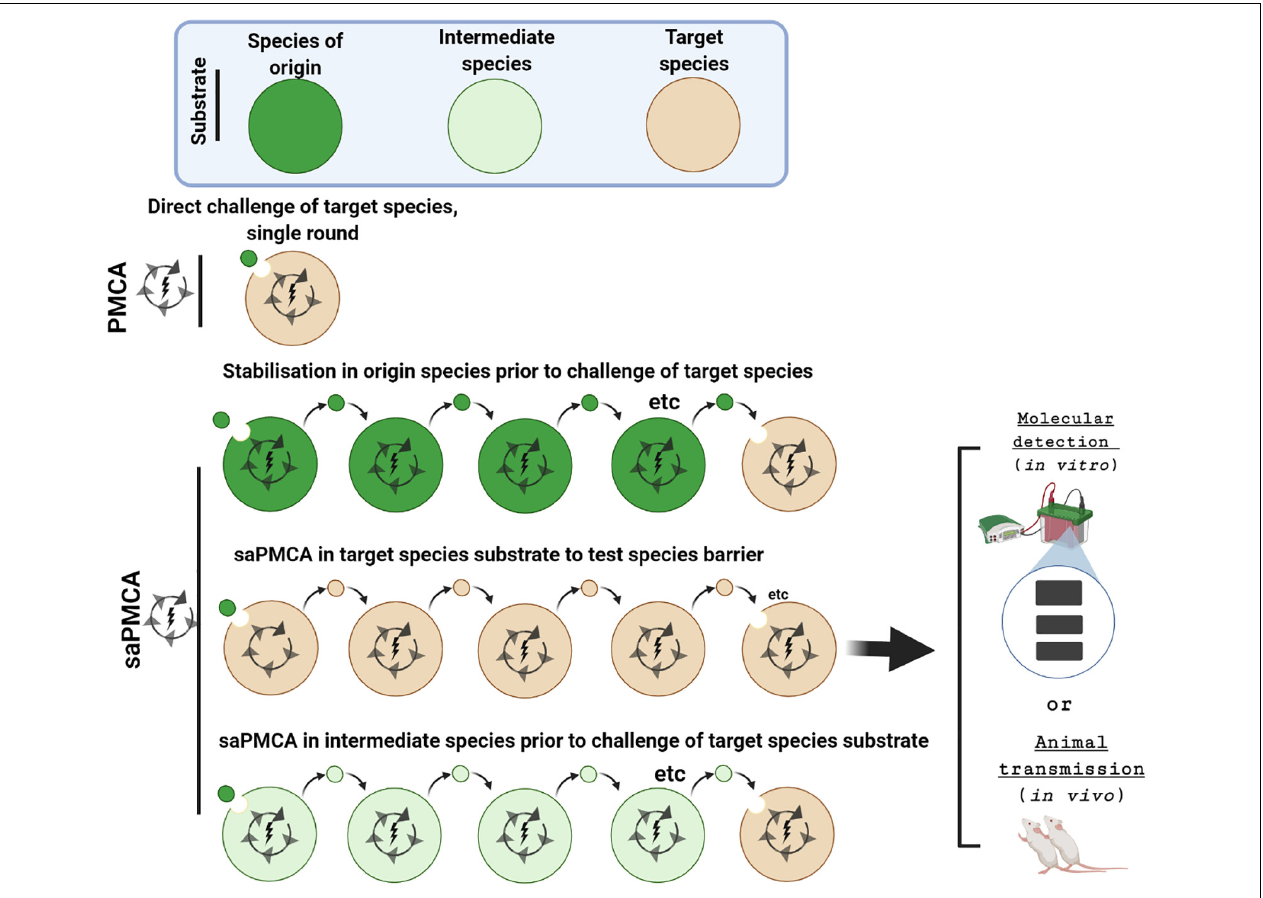
FIGURE 3 | Investigating inter-species transmissibility by PMCA and saPMCA. The potential for a prion strain to cross the species barrier between the species of origin (dark green) and the target species (brown) can be assessed by a single round PMCA experiment. Alternatively, in serial automated PMCA (saPMCA), the amplification phase can be extended by multiple rounds in which the seed from one round is diluted into fresh PrP C substrate. Multiple rounds of saPMCA using PrP C from the species of origin might stabilize a prion strain to increase inter-species transmissibility. Alternatively, saPMCA with target species PrP C could be used to examine the potential for a strain to adapt to a new replication environment. Finally, saPMCA can be used to address whether propagation with PrP C from an intermediate species (light green) facilitates transmission to the target